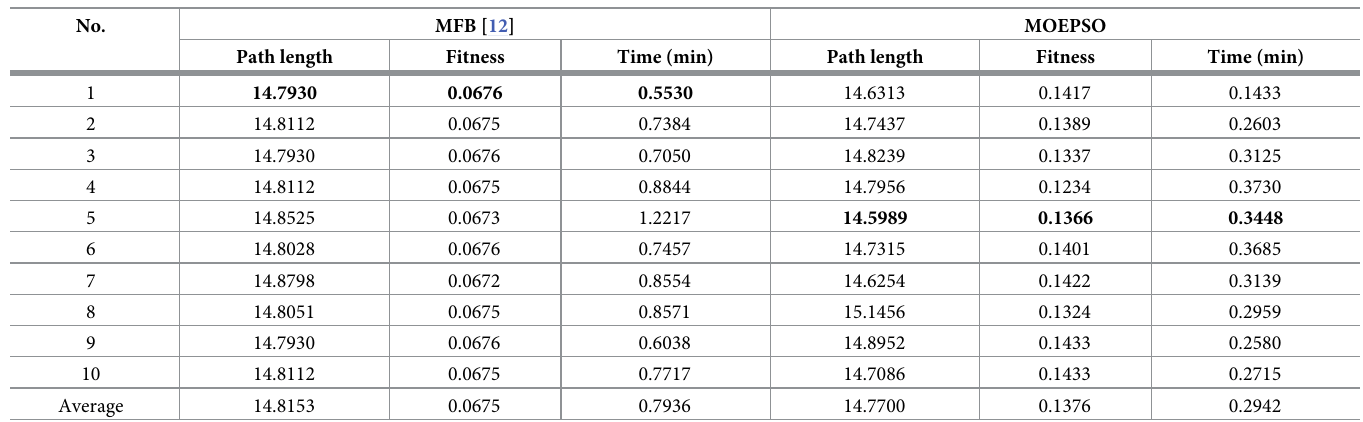
Table 7. Path planning results in the static environment (5 obstacles).